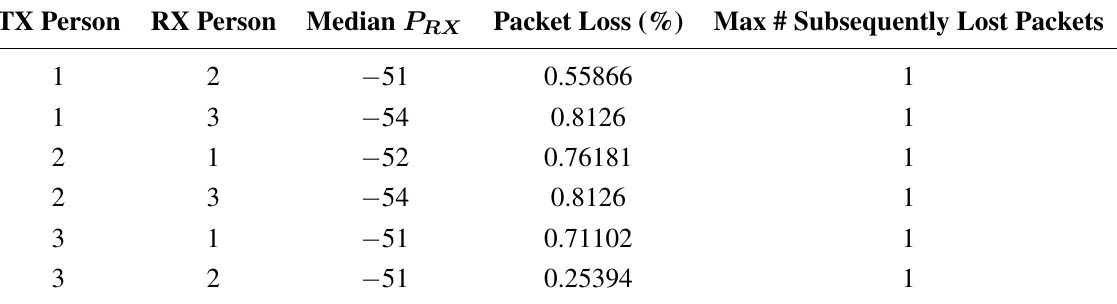
Table 4. Median received power and packet loss for the person-to-person